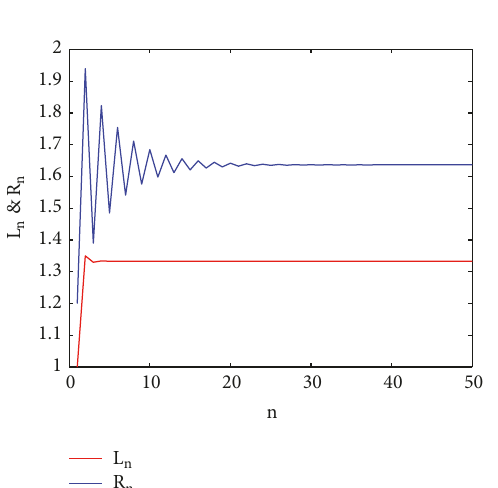
Figure 2: The solution of system (64) at 𝛼 = 0 .